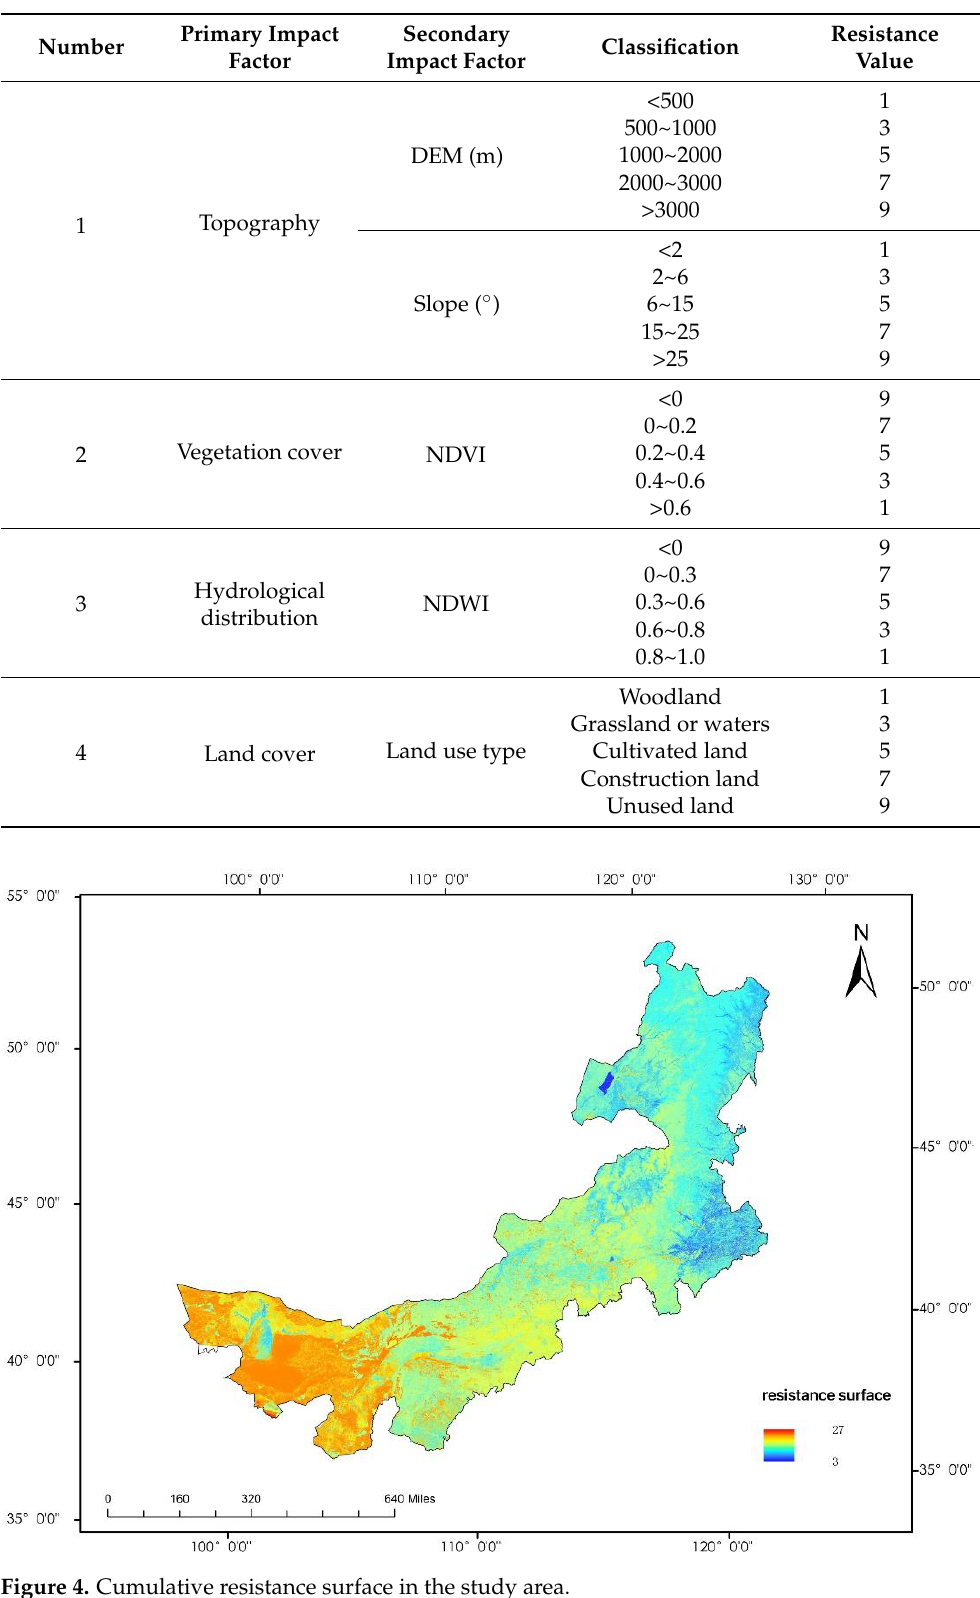
Table 1. Classification and value of ecological resistance factors.